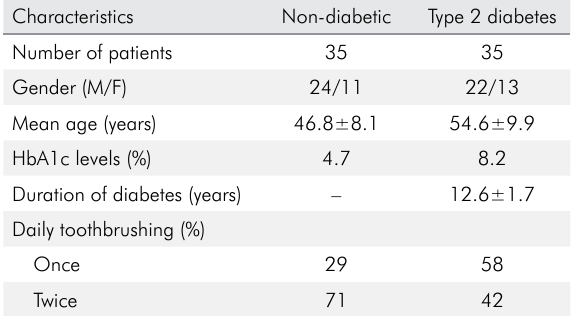
Table 1. Demographic characteristics of study participants.